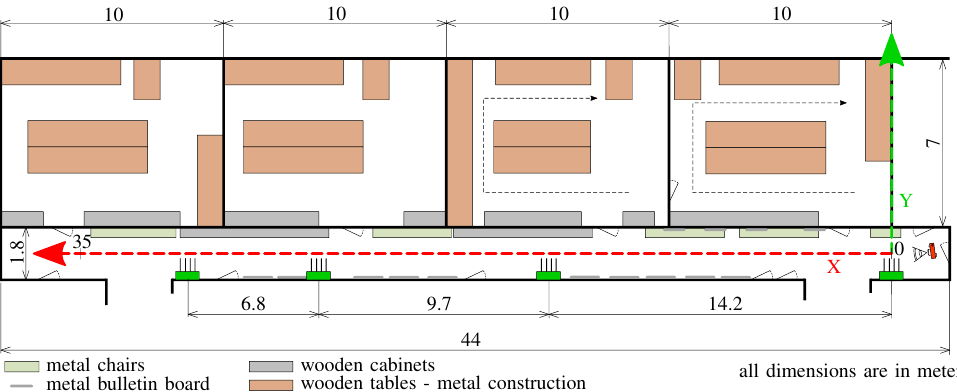
Figure 3. Measurement scenario and floor plan. Green boxes denote the anchors. The height of the Fig. 3. Measurement scenario and floor plan. Green boxes denote the anchors. anchors is 2.2m above the floor level, the height of tags is 1.0m. Scale of X axis and Y axis is different. Room dimensions are